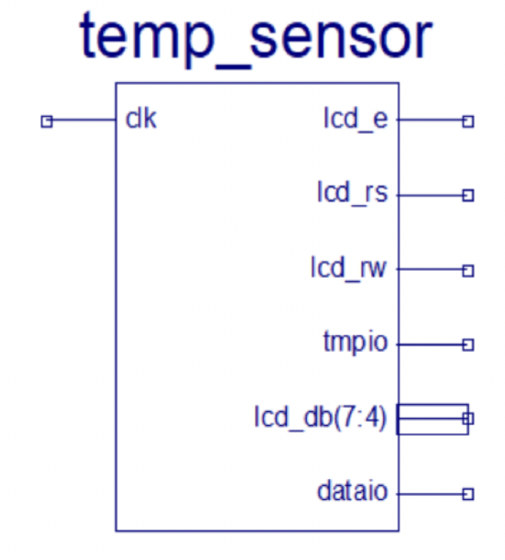
Figure 7. The unit designed for temperature and humidity